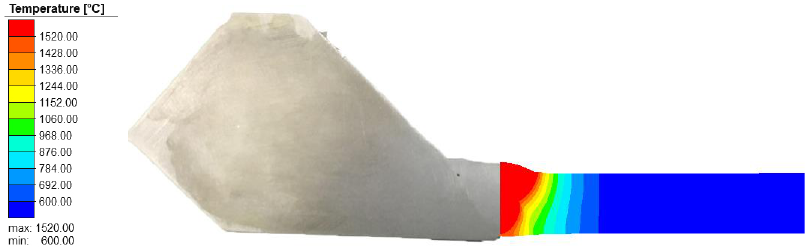
Figure 8. The shape of the weld pool obtained through experiments and finite element simula- tions.